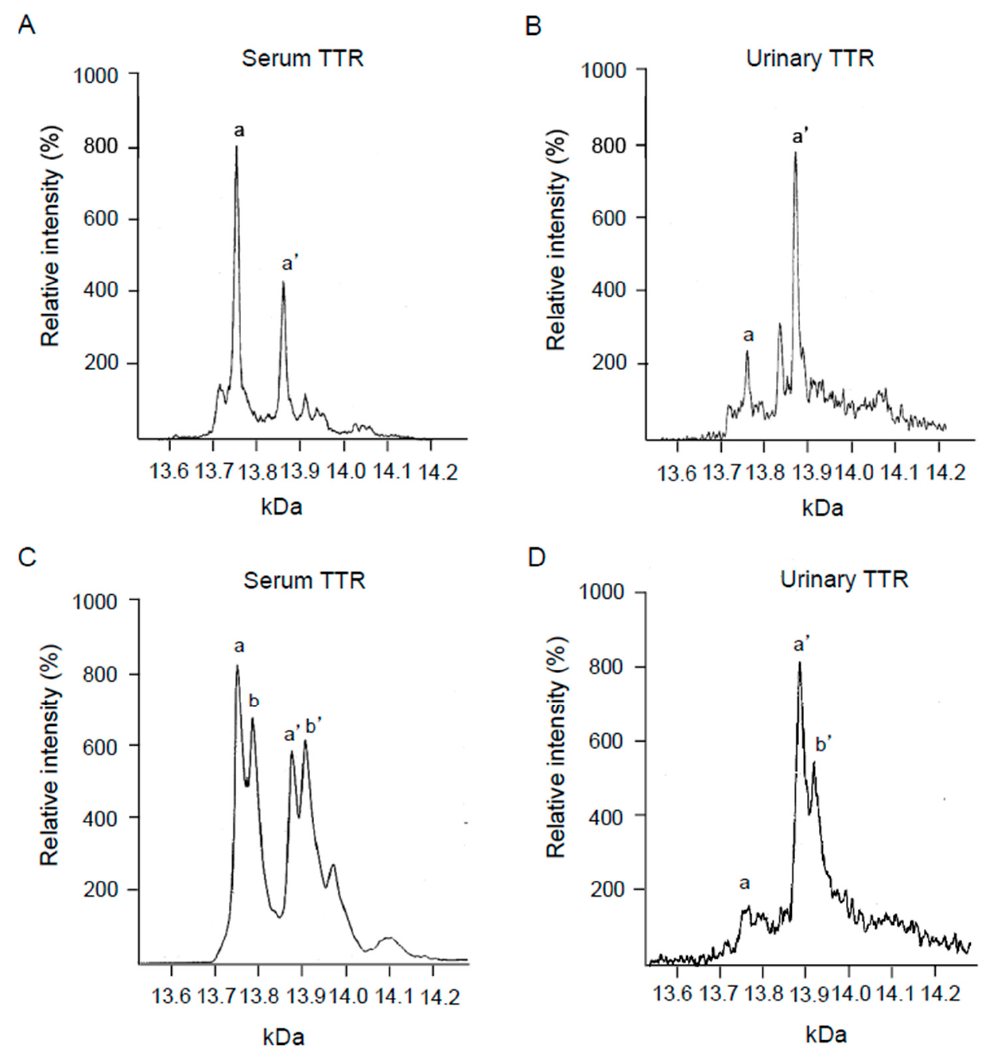
Figure 4. MS analysis for urinary TTR. ( A ) Serum from healthy subjects (No. 3 in Table 1), ( B ) urine from healthy subjects (No. 15 in Table 1), ( C ) serum from patients with ATTRv V50M amyloidosis (No. 10 in Table 1), and ( D ) urine from patients with ATTRv V50M amyloidosis (No. 11 in Table 1). a: normal TTR, a ′ : cysteine-binding normal TTR, b: ATTRv V50M, and b ′ : cysteine-binding ATTRv V50M.